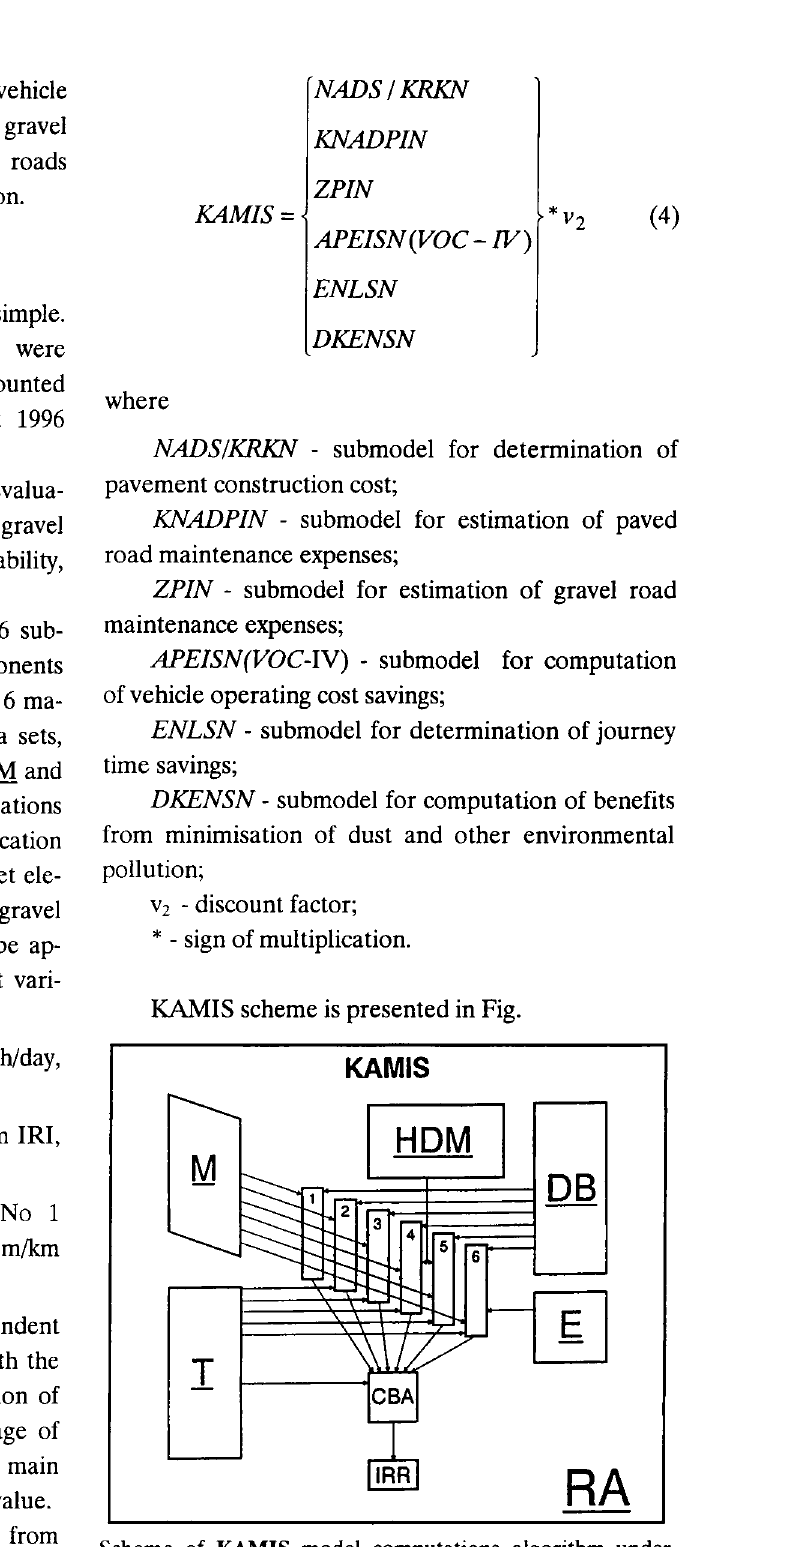
Scheme of KAMIS model computations algorithm